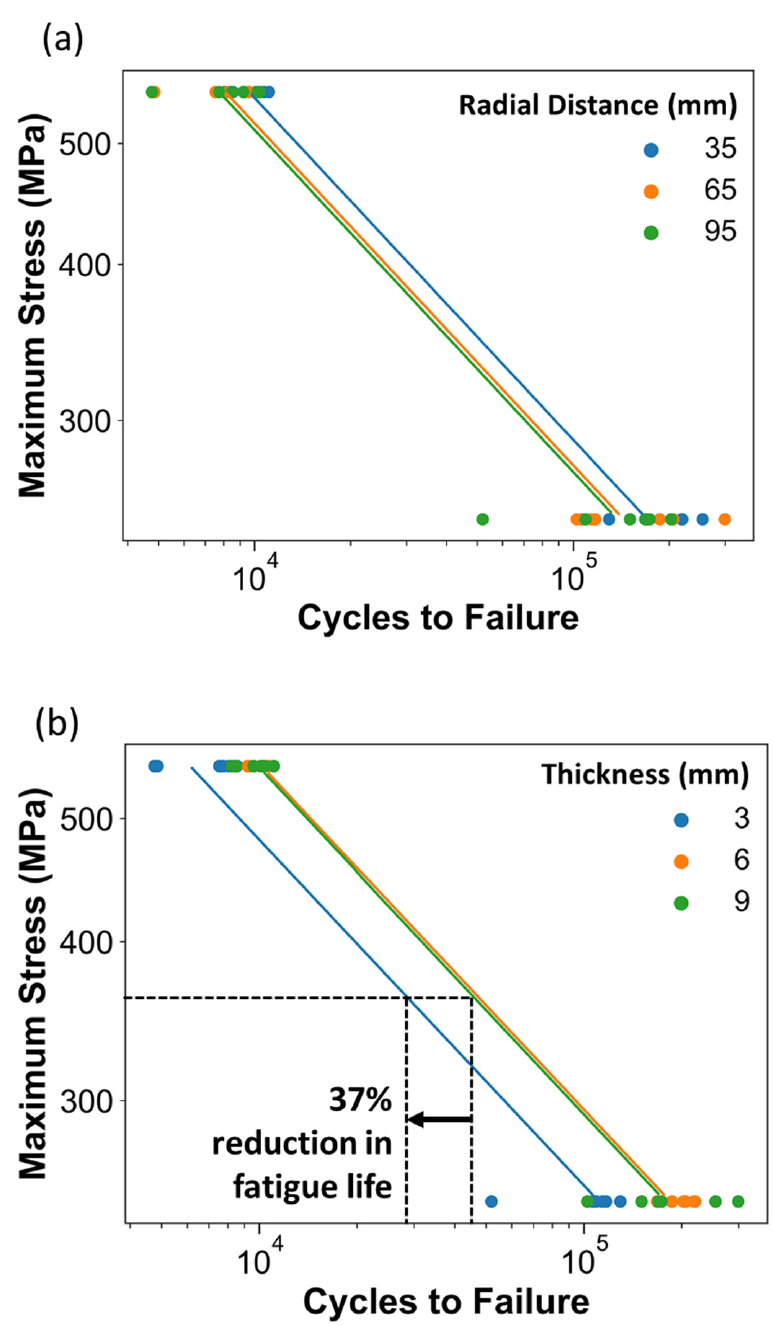
Figure 4. Stress–life diagrams of data from the DOE with metal in the as-built condition and with Basquin model fits. Shown are the effects of ( a ) radial distance, and ( b ) thickness factors.